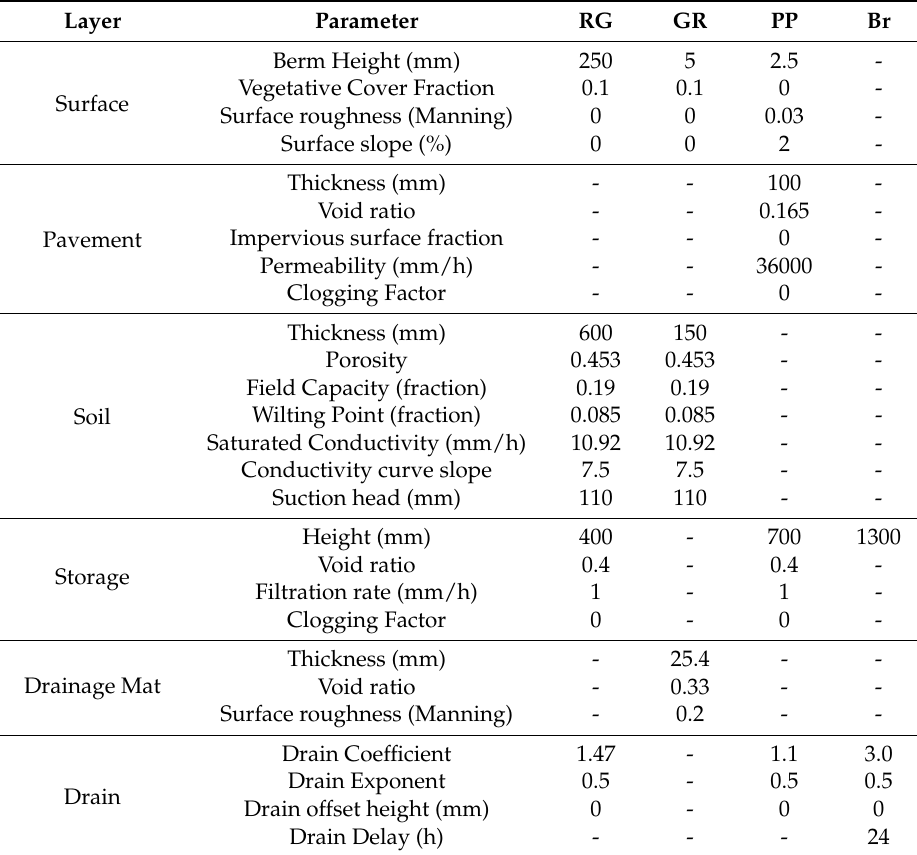
Table 5. BMP parameters used in the Personal Computer Storm Water Management Model (PCSWMM)